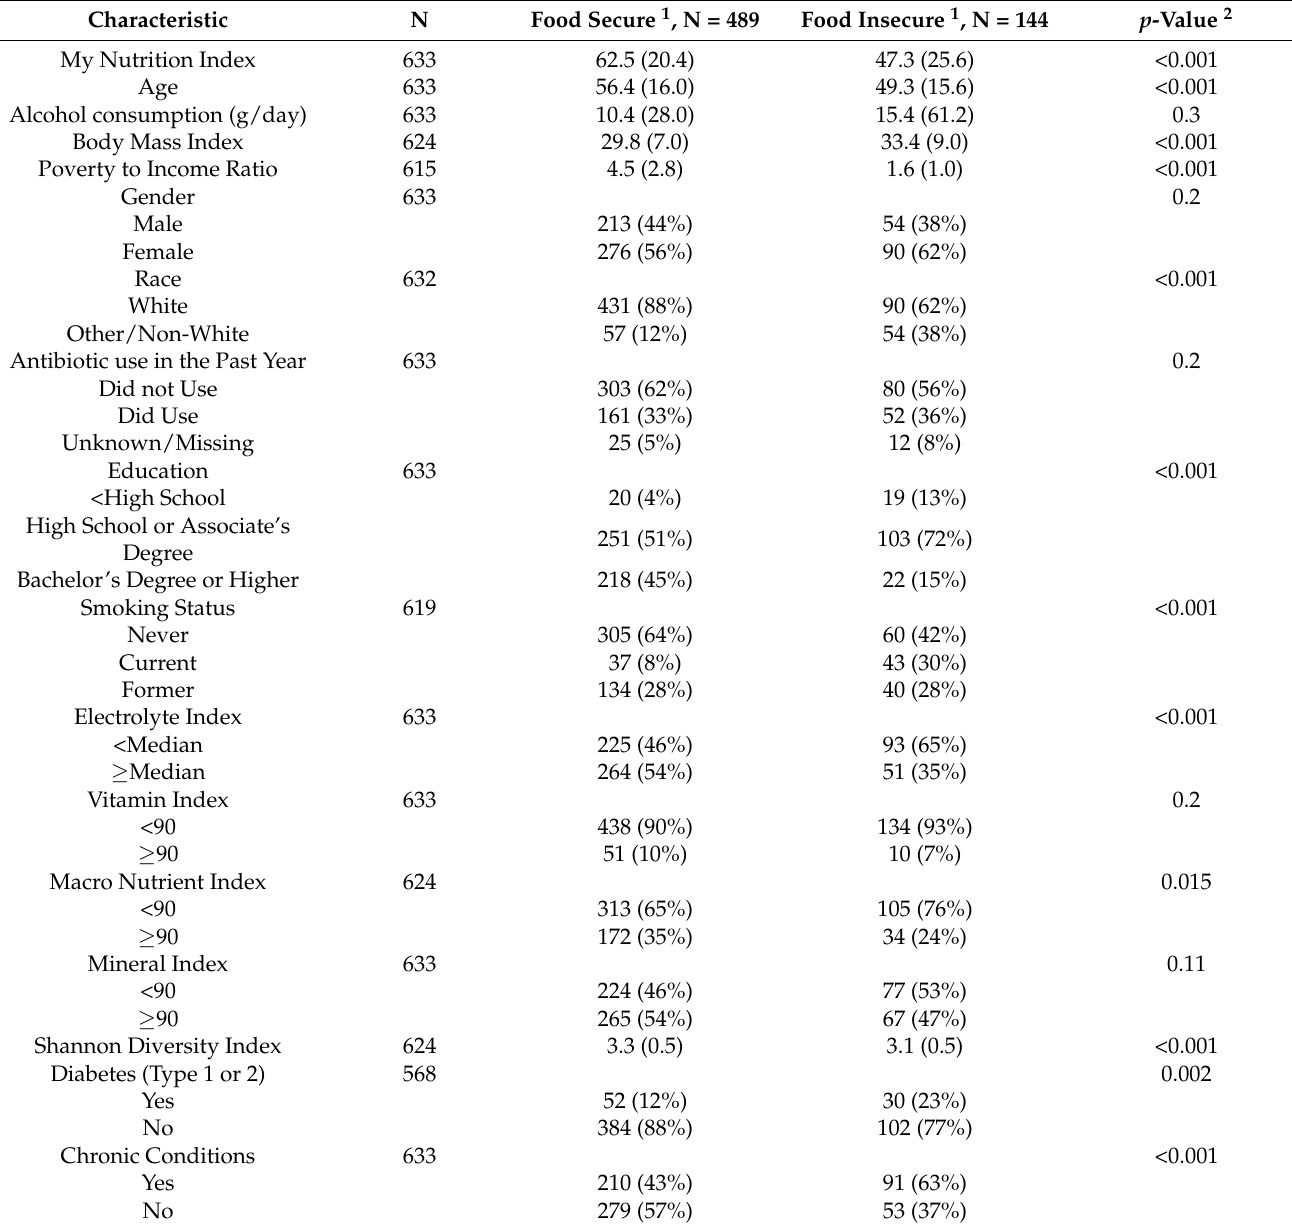
Table 1. Characteristics and demographics of subjects stratified by food security